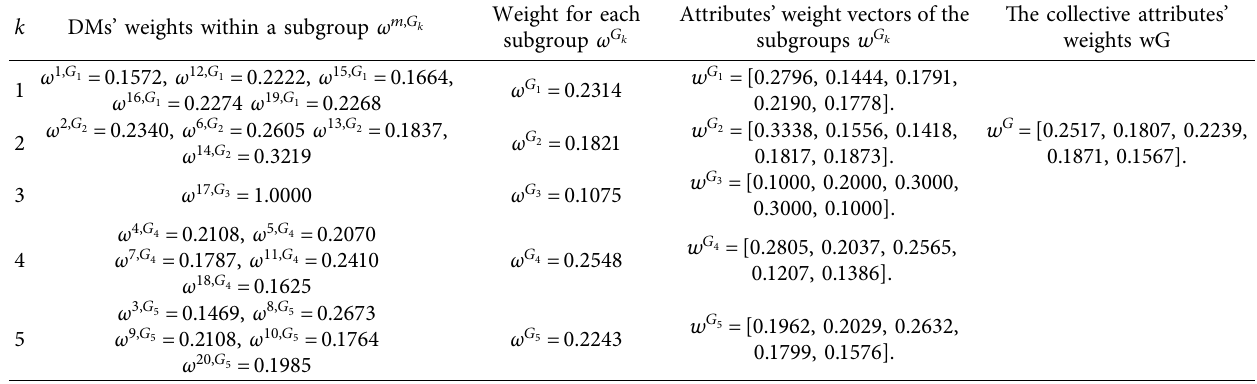
Table 2: .e final weight results.